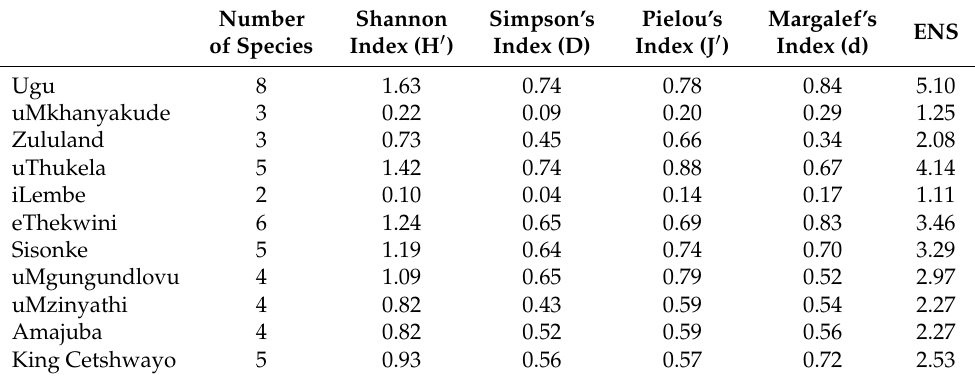
Table 2. Biodiversity indices of snail species in 11 districts in KZN between December 2020 and February 2021.